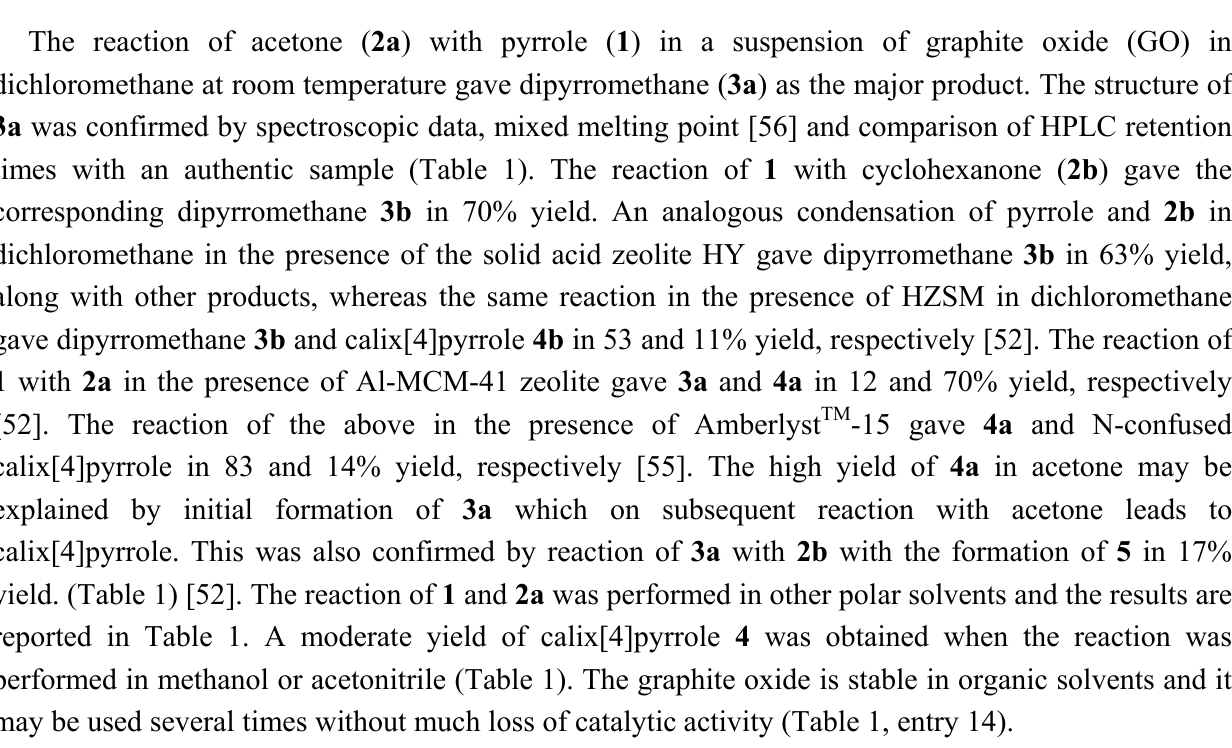
Table 1. Graphite oxide catalyzed condensation of pyrrole and acetone in different solvents a . Entry